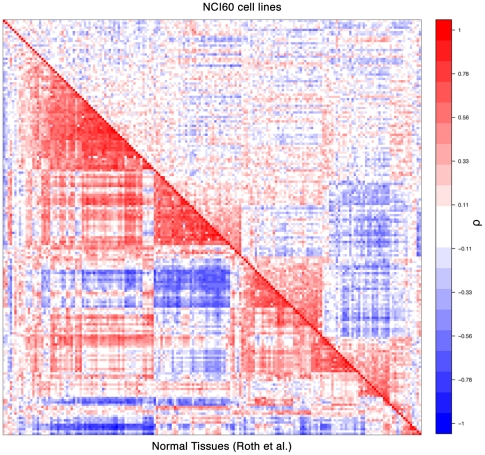
Reduced correlations of activities between pathways in cancer cell lines respect to normal tissues.The bottom left half shows the correlation matrix for 186 KEGG pathways in normal tissues. The top right half shows the correlation matrix for 186 KEGG pathways in NCI-60 cell lines.